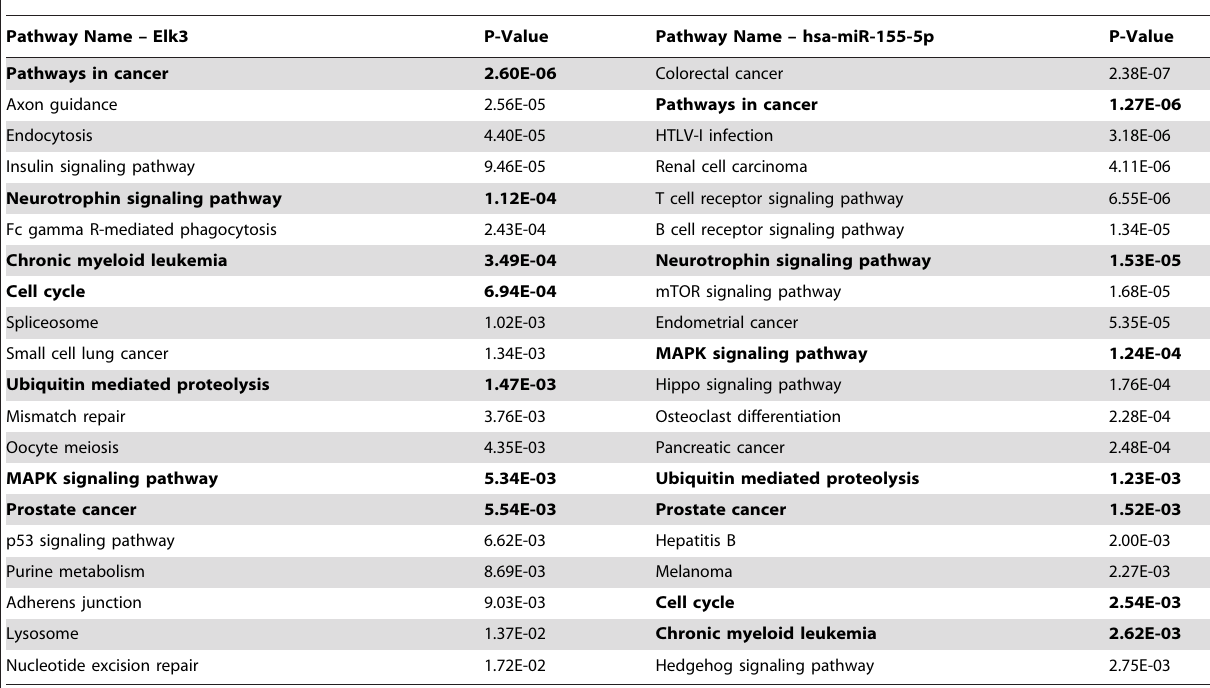
Table 1. Elk3/hsa-miR-155-5p KEGG pathway correlation.